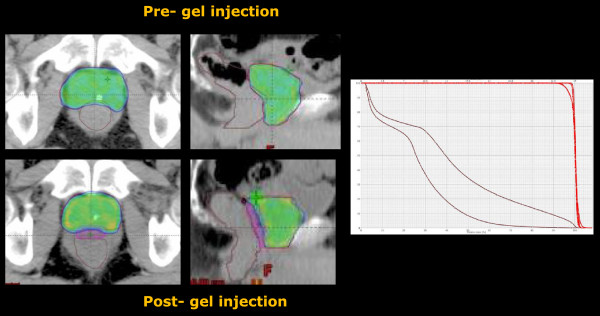
The potential dosimetric role of SpaceOAR™ gel implantation: dose distribution and DVH for a study patient where double CT scan and double planning was performed. Data are shown for CTV, PTV and rectum. No differences were observed for the target volumes while remarkable difference was observed in this case for the rectum.